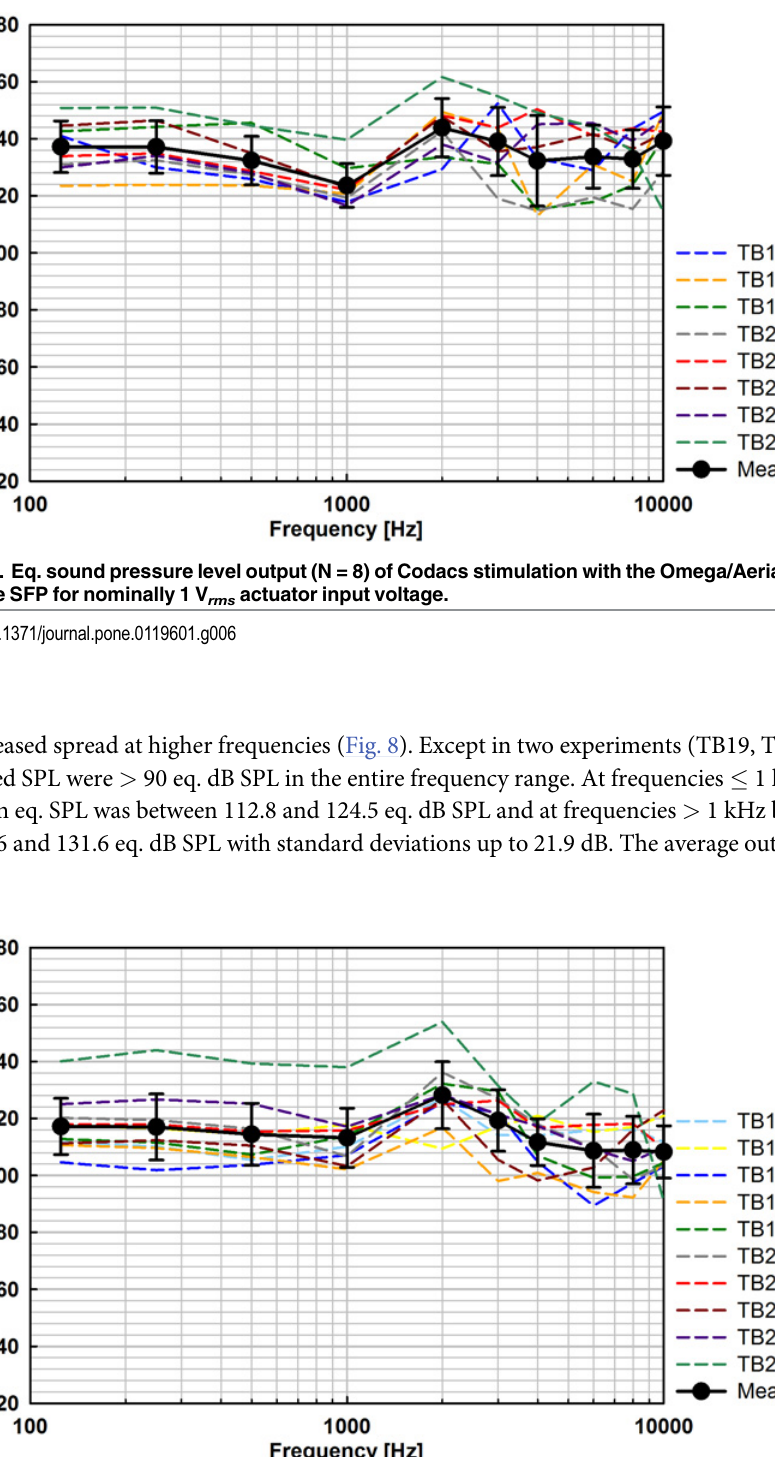
Fig 7. Eq. sound pressure level output (N = 10) obtained in Codacs stimulation of the RW membrane at nominally 1 V rms actuator input voltage.